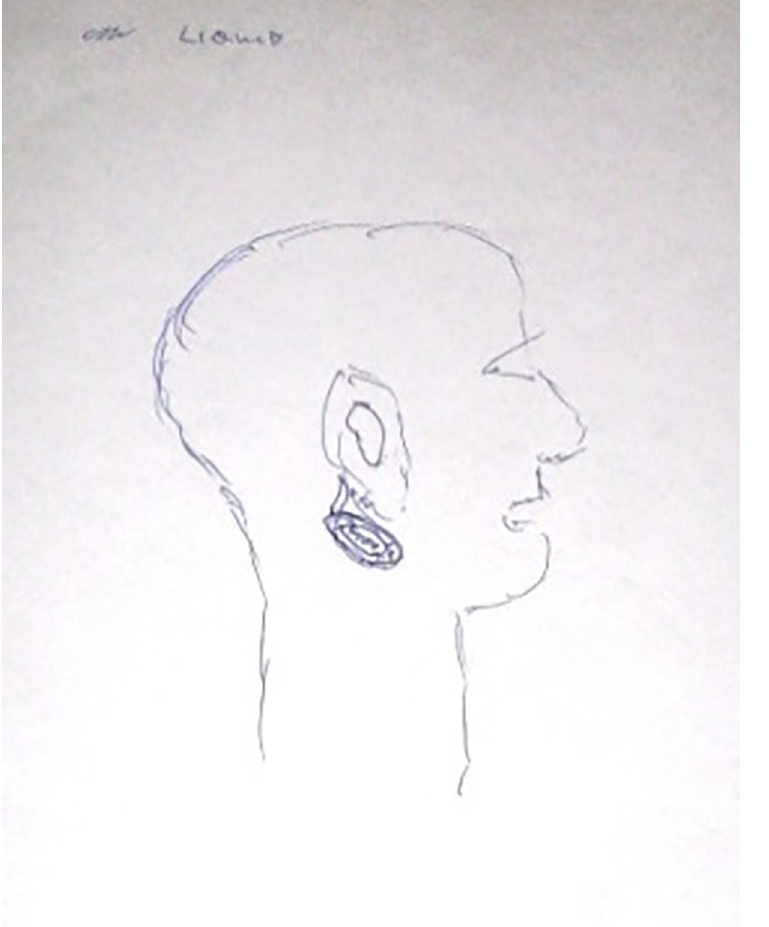
Fig 9. Scott, T1, Cancer in neck